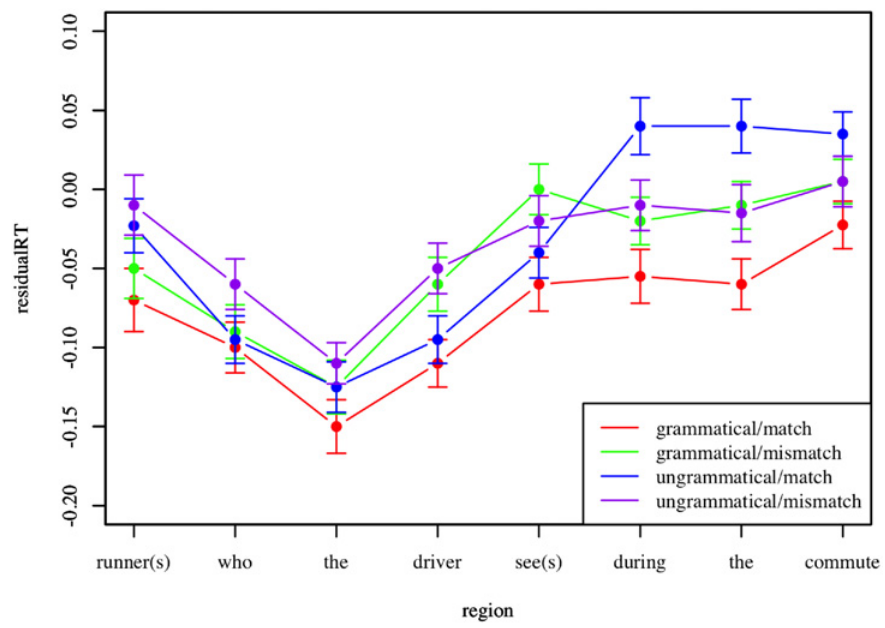
Fig 5. Agreement attraction with RC modifiers. Mean residual reading time is plotted by region for each condition in Experiment 3. Error bars represent standard error of the mean.